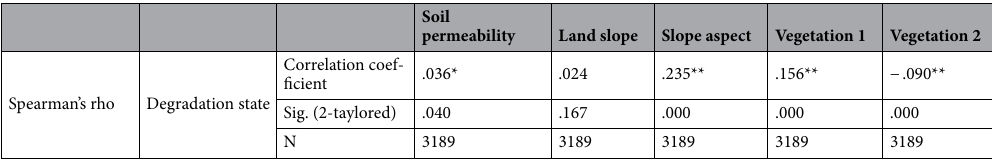
Table 2. Correlation between degradation state and the HI index variables, which belong to the WRASTIC-HI index. *Correlation is significant at the 0.05 level (2-tailed), **Correlation is significant at the 0.01 level (2-tailed).